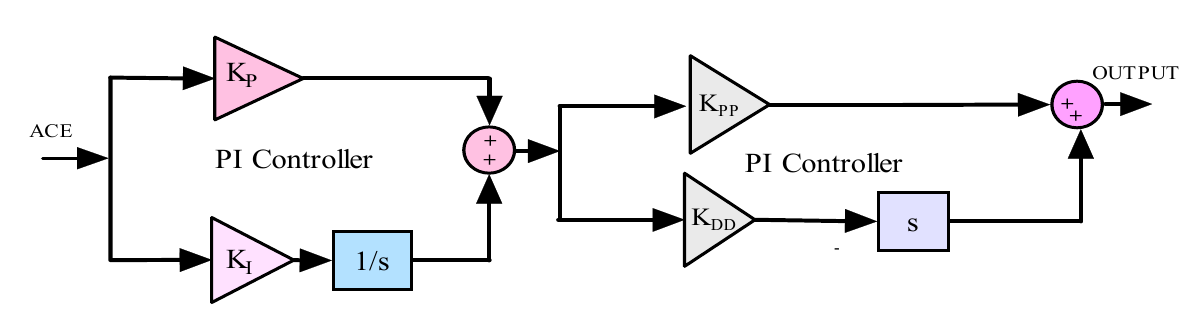
Figure 9. Cascade PI-PD controller .